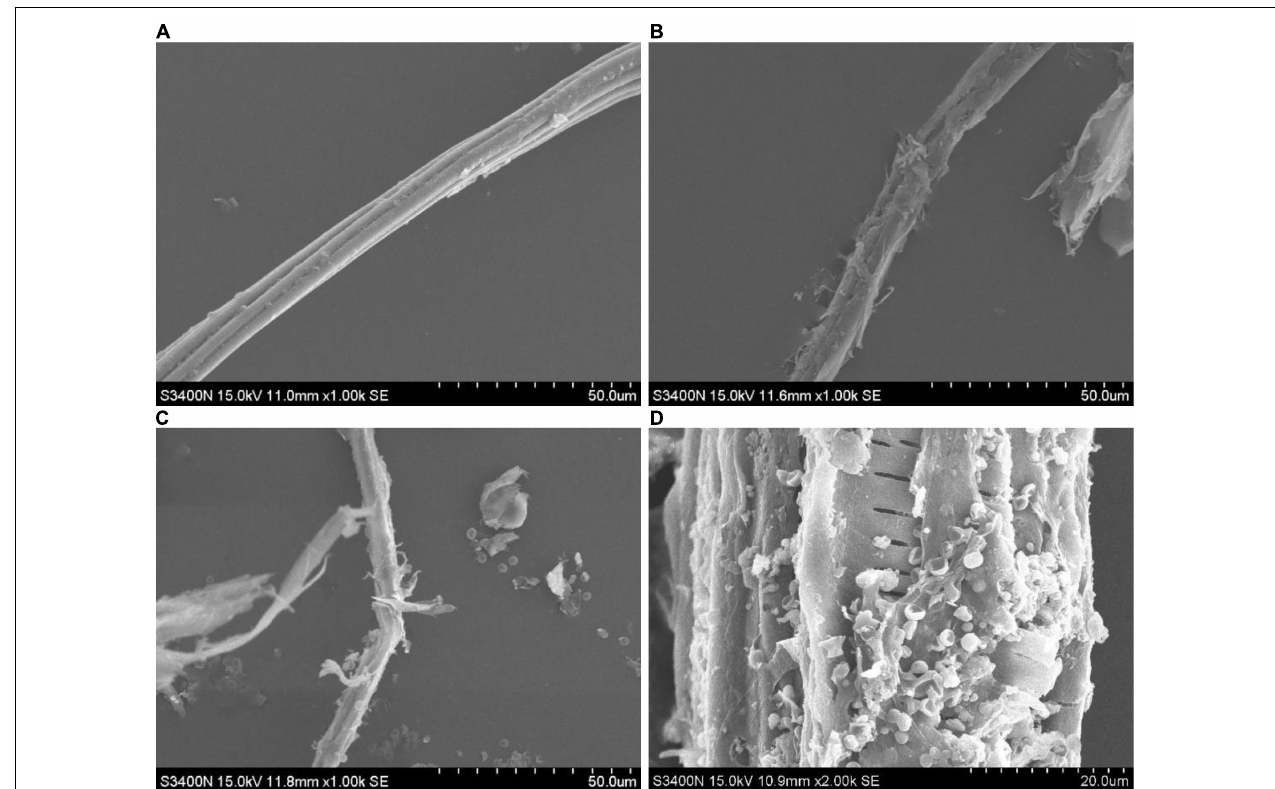
FIGURE 6 | SEM image of moso bamboo culture medium. Samples of the moso bamboo raw material, after pretreatment and after fermentation were scanned using a 3400-I scanning electron microscope. (A) Moso bamboo material. (B) Material pretreated by disk milling. (C) Moso bamboo culture medium after fermentation at 1,000 (cid:5) magnification. (D) Moso bamboo culture medium after fermentation at 2,000 (cid:5)